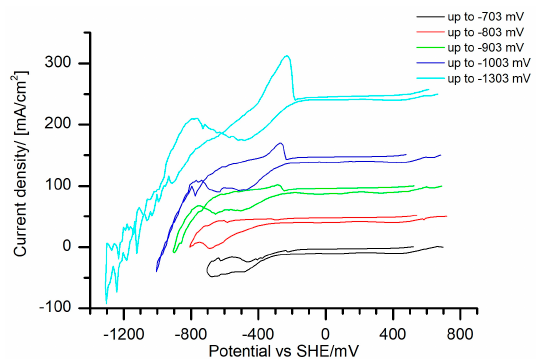
Figure 4. CVs in single metal Fe(III)-tartrate electrolyte recorded with the scan rate of 50 mV / s at the pH value of 1.8. The cathodic reverse potential was varied from − 703 to − 1303 mV vs. SHE. The position of Fe reduction potential was estimated according to the appearance of the anodic dissolution peak.